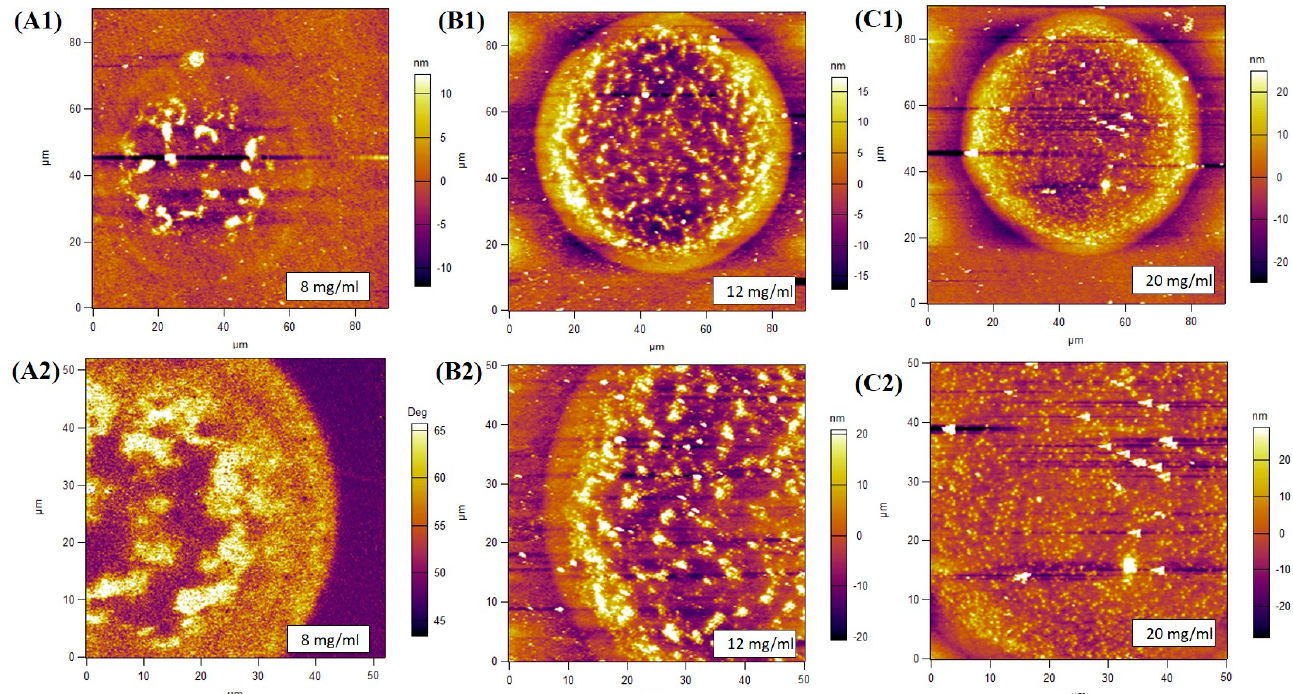
Figure 6. AFM ( 1 ) height and ( 2 ) phase images of PVDF/DMF/AC solution S ‐ droplets with various concentrations. ( A ) 8 mg/mL, ( B ) 12 mg/mL, ( C ) 20 mg/mL.